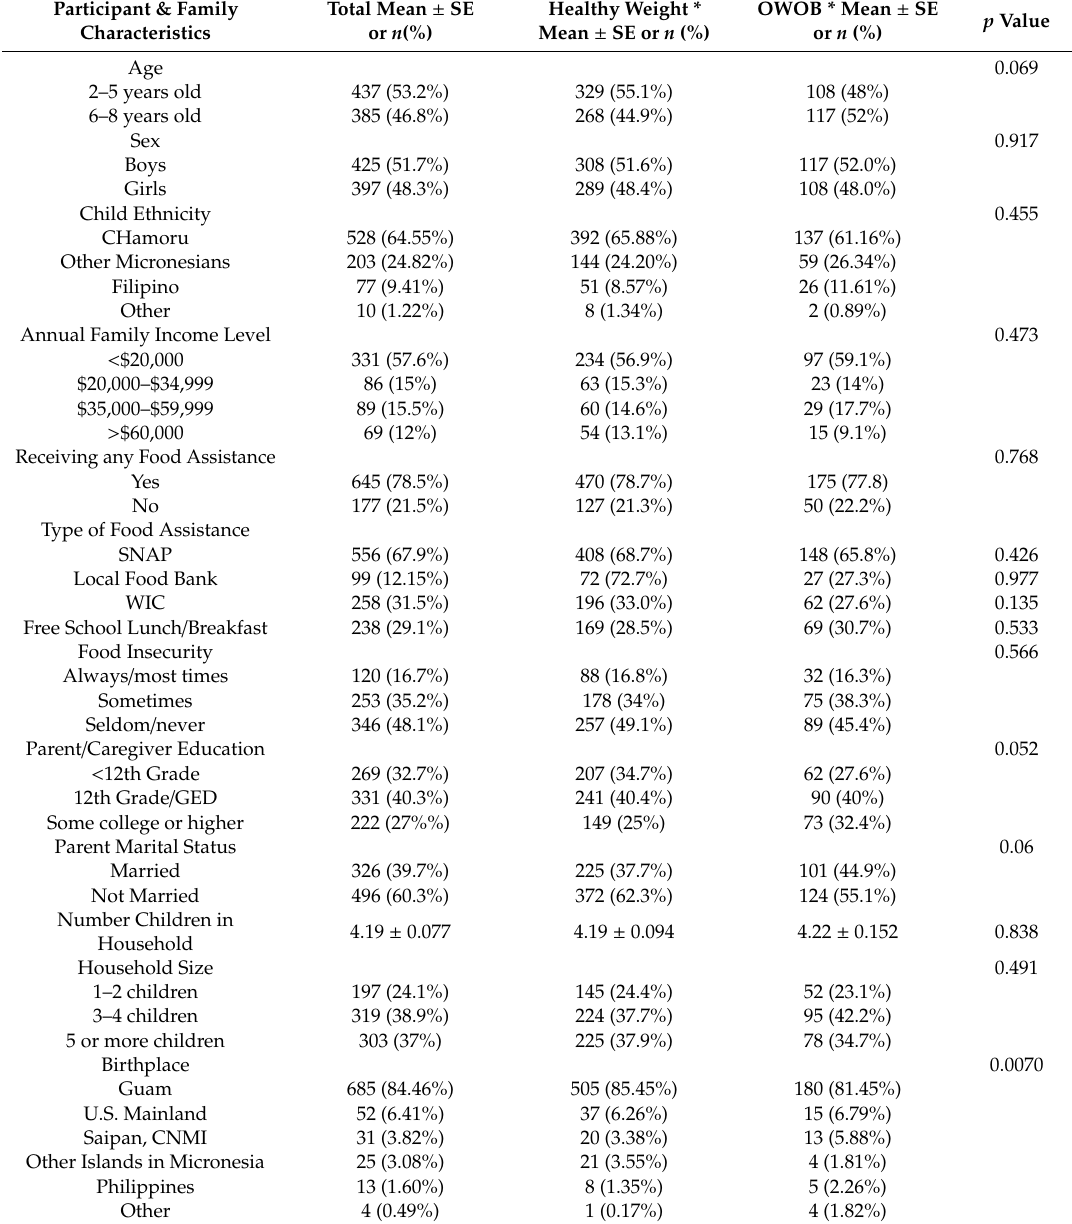
Table 2. Characteristics of child participants from Guam in the Children’s Healthy Living (CHL) Program stratified by BMI